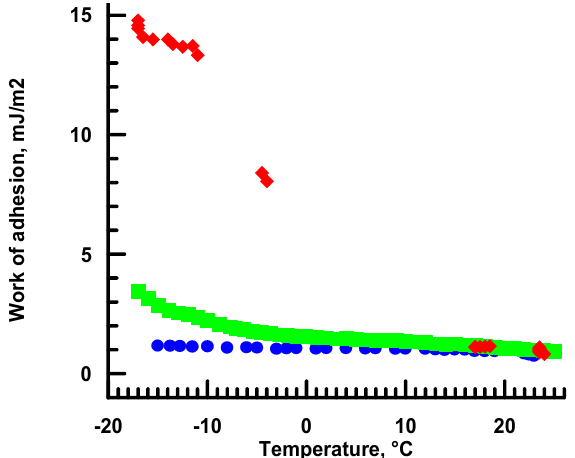
Figure 2. Practical work of adhesion for liquid aqueous droplet (supercooled liquid at negative temperatures): red diamonds—for water on superhydrophobic PDMS [13]; green squares—for 0.5 M NaCl aqueous solutions on superhydrophobic aluminum substrates [23]; blue circles—for water on superhydrophobic aluminum substrates [23].